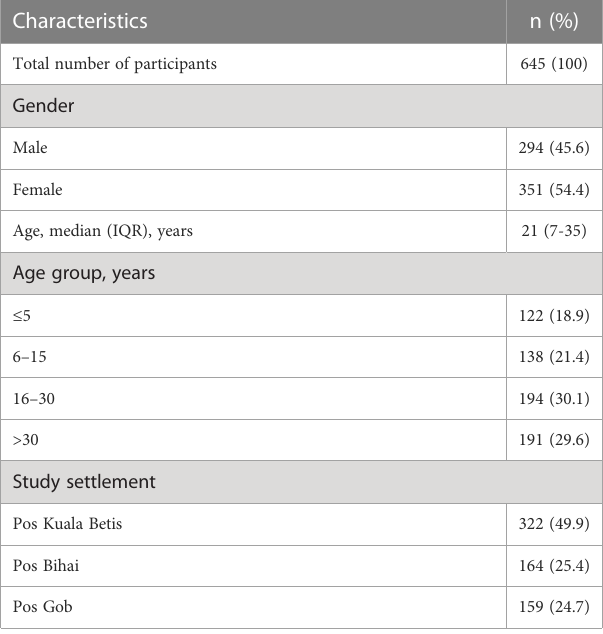
IQR = interquartile